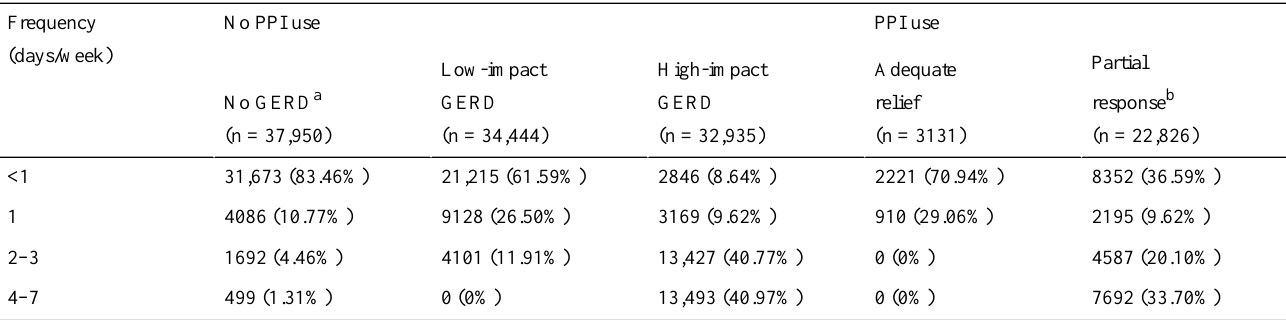
Table 2. Frequency of over-the-counter medication use in respondents with and without proton pump inhibitor (PPI) use.